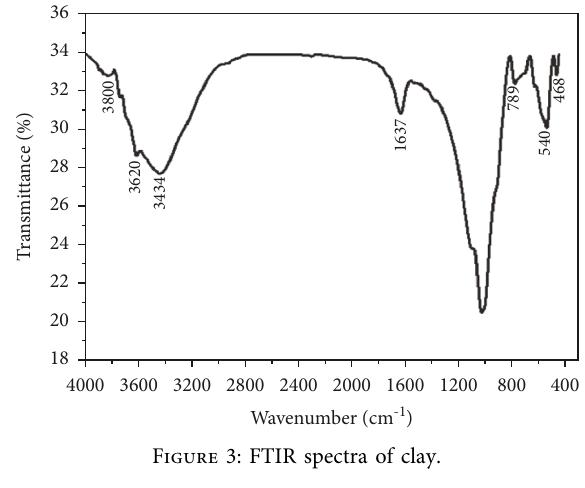
Figure 3: FTIR spectra of clay.